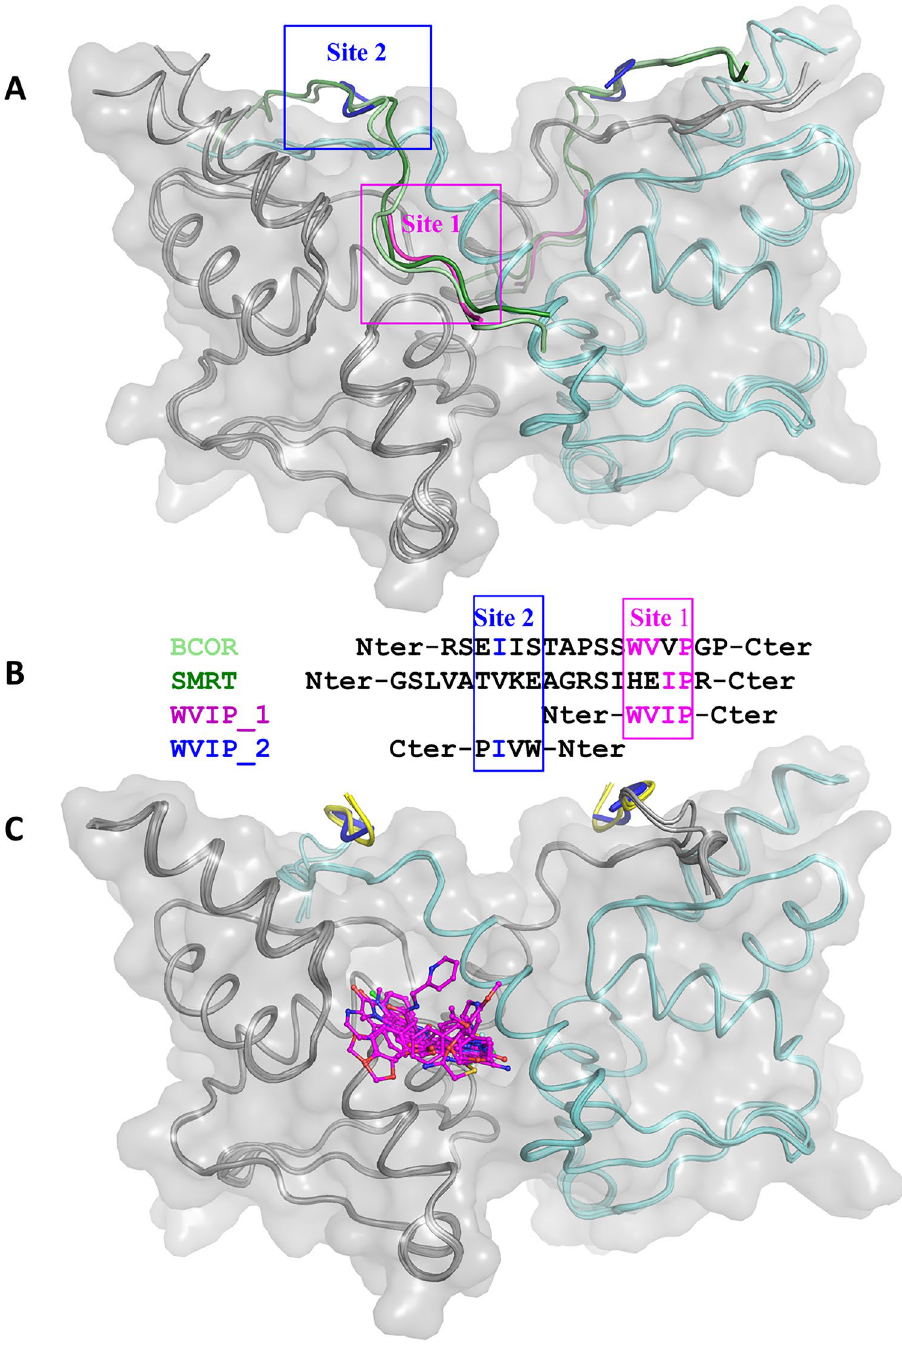
Figure 4. Natural corepressors, WVIP peptide, and HTS hits bind to the same area on the surface of BCL6 BTB domain dimer. ( A ) Overlay of the BCL6 BTB domain dimer bound to the SMRT corepressor peptide (dark green, PDB ID 1R2B), the BCOR corepressor peptide (light green, PDB ID 3BIM) and the WVIP peptide bound at site 1 (magenta) and site 2 (blue). The BCL6 dimer is shown in ribbon representation with the two individual monomers coloured in grey and cyan with a grey semi-transparent surface superimposed. ( B ) Sequence alignment reflecting the structural overlay of the corepressors and the two molecules of the WVIP peptide bound at site 1 and site 2, respectively. ( C ) Overlay of BCL6 BTB domain dimer bound to the 12 structurally confirmed HTS hits (magenta). The colour scheme and surface representation of the BCL6 dimer are the same as in panel ( A ). The HTS hits are shown as magenta ball and sticks. The N -terminal uncleaved TEV sequence present in the Flag-TEV-BCL6 construct, used for some of the BCL6-inhibitor structures and binding at the second WVIP binding site (site 2), is shown as a yellow